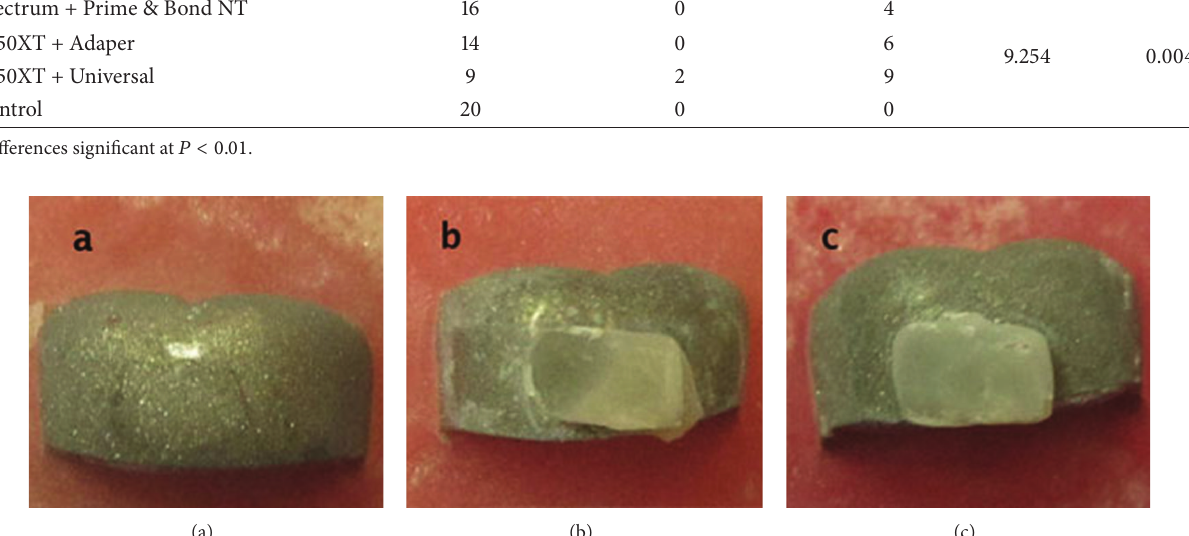
Figure 2: Types of failure of shear bond strength: (a) adhesive failure, (b) mixed failure, and (c) cohesive